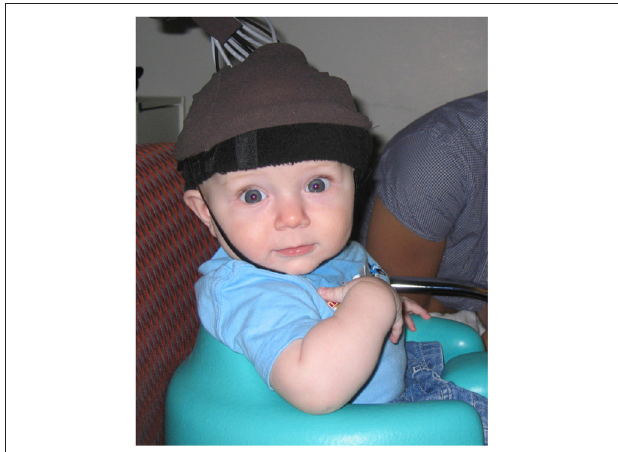
FIGURE 3 | An infant participant. Infants sat in a supportive seat to restrain excess movement. An elasticized headband containing a rubberized piece in which the sources and detectors were embedded was slid onto the infant’s head and secured by a chinstrap. Parental consent was obtained for use of the photograph for publication